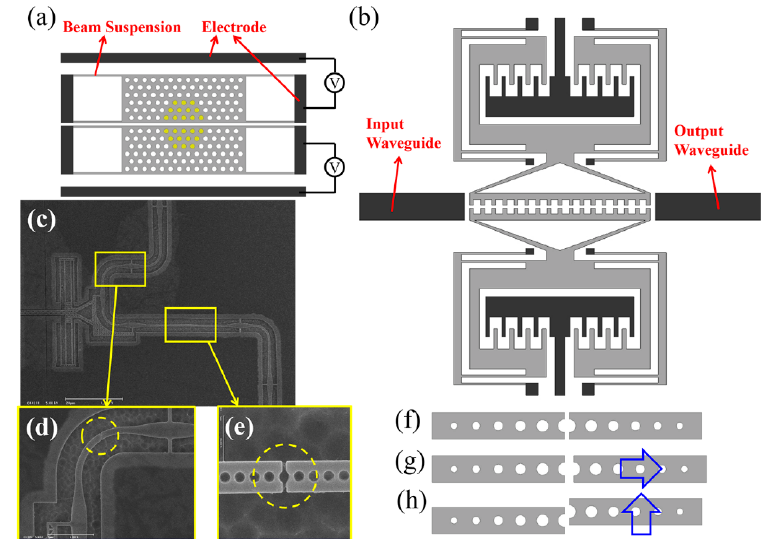
Figure 11. ( a ) Schematic of a tunable air-slot 2D PhC cavity with integrated electrostatic actuators. The yellow holes denote the defect region of the 2D PhC slab. ( b ) Schematic of a tunable transversely split nanobeam cavity. ( c ) SEM image of a tunable longitudinally split nanobeam cavity with close-up views given in ( d ) and ( e ). ( f ) Schematic of a longitudinally split nanobeam cavity with different tuning directions given in ( g ) and ( h ).